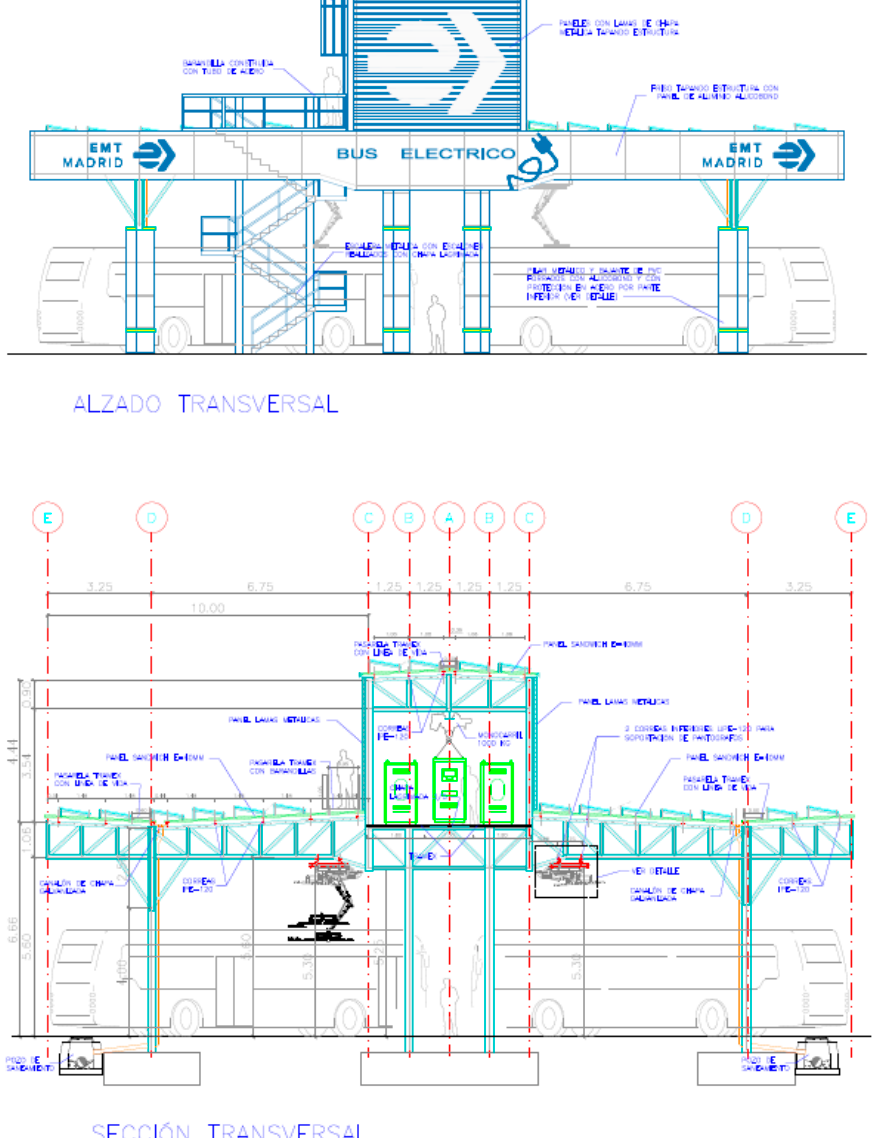
Figure 6. Real designs of inverted pantographs under construction for 25 buses of 12 m lenght e-buses in Carabanchel OC (Madrid).